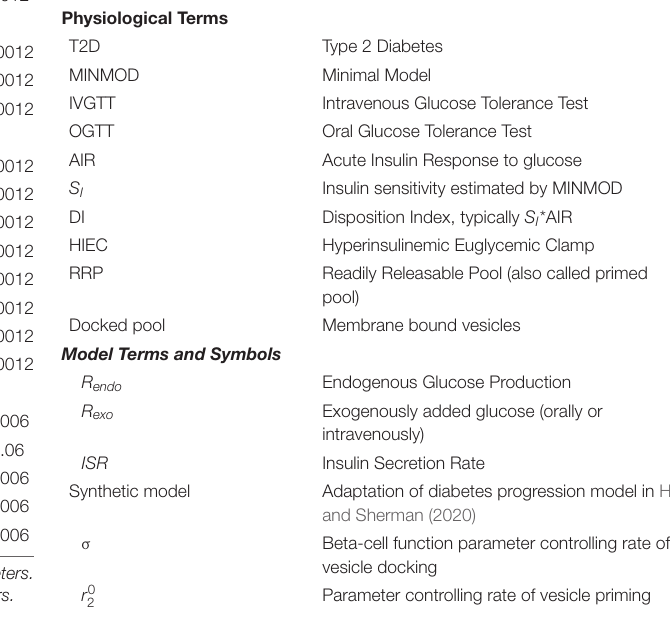
TABLE 2 | List of acronyms, terminology and